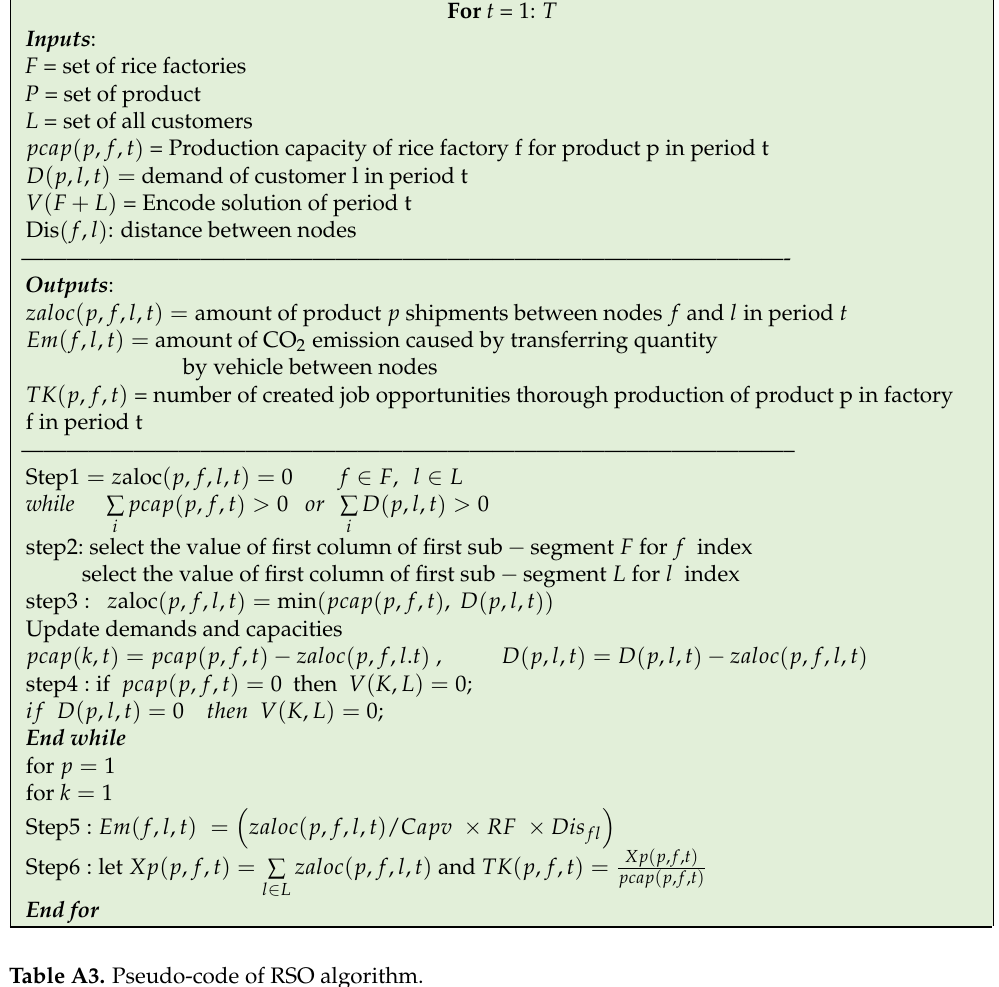
Table A2. The proposed priority-based decoding procedure of segment 3.